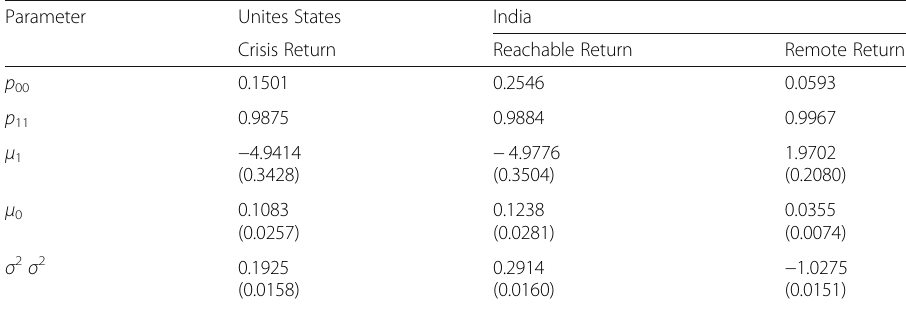
Table 2 Parameter estimates for Markov Regime-Switching Model from April 2007 to June 2016 Parameter Unites